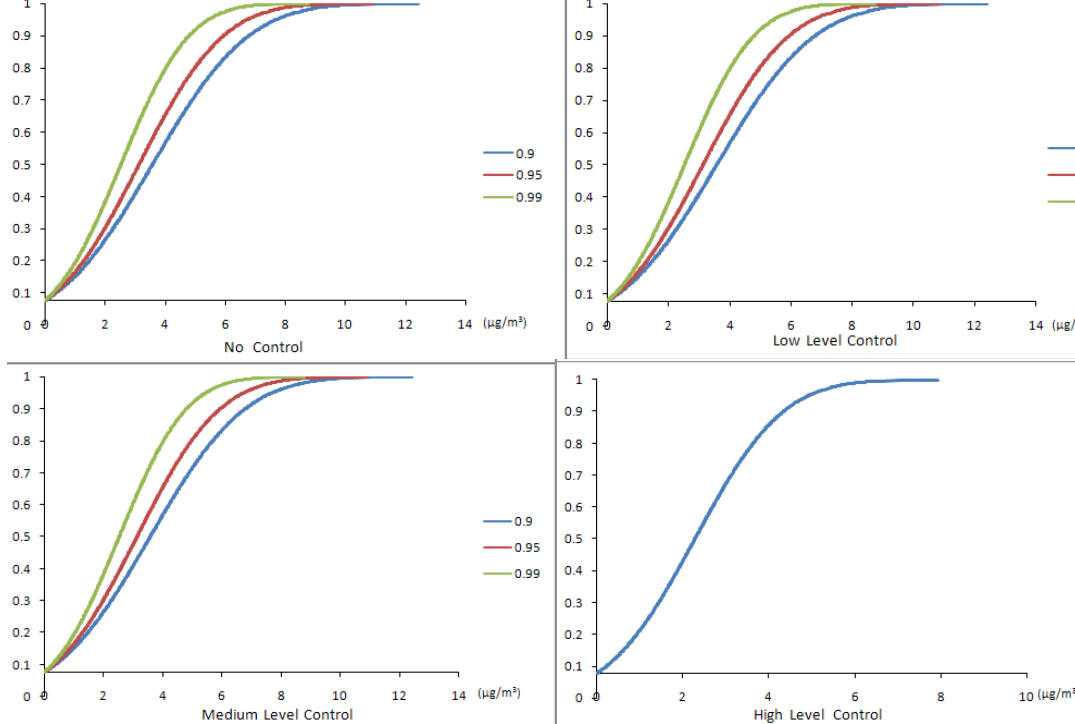
Figure 5. Cumulative probability distributions of SWNT exposure results from CCP method.